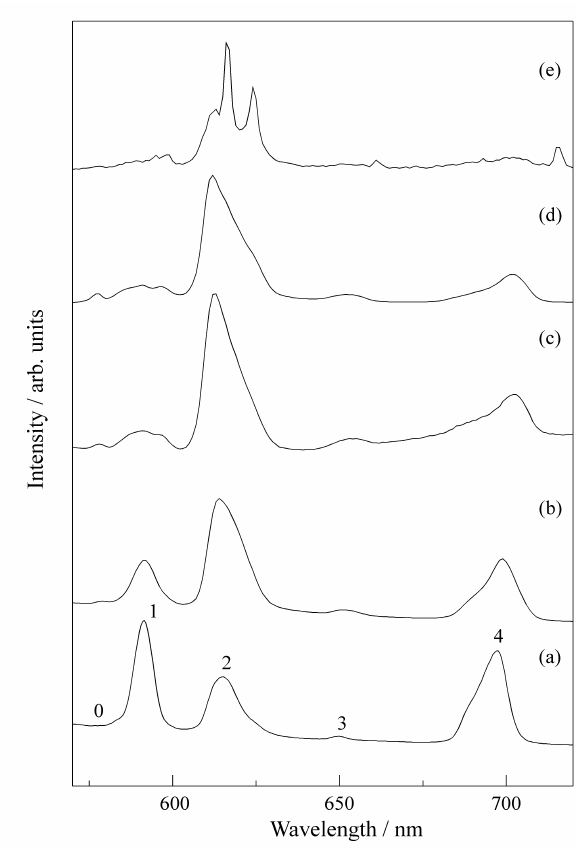
Figure 3. Eu 3+ 5 D 0 emisson spectra in the SiO 2 -TiO 2 system (0.5% mol Eu 3+ ). (a) Wet gel ( t ( 5 D 0 ) = 0.24 ms); (b) Dried gel 130 °C ( t ( 5 D 0 ) = 0.92 ms); (c) Dried film 500 °C ( t ( 5 D 0 ) = 2.40 ms); (d) Dried gel 800 °C